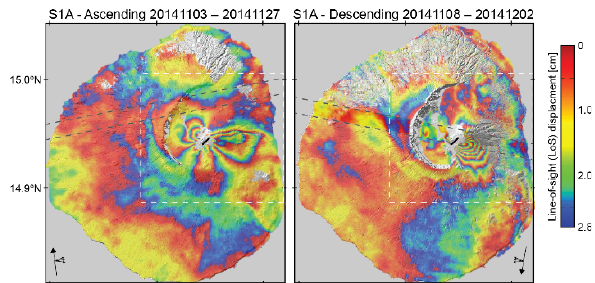
Figure 5. Sentinel-1 interferograms of the 2014-2015 eruption at Fogo Island. In the panels we show the location of the burst boundaries, denoting the burst overlap